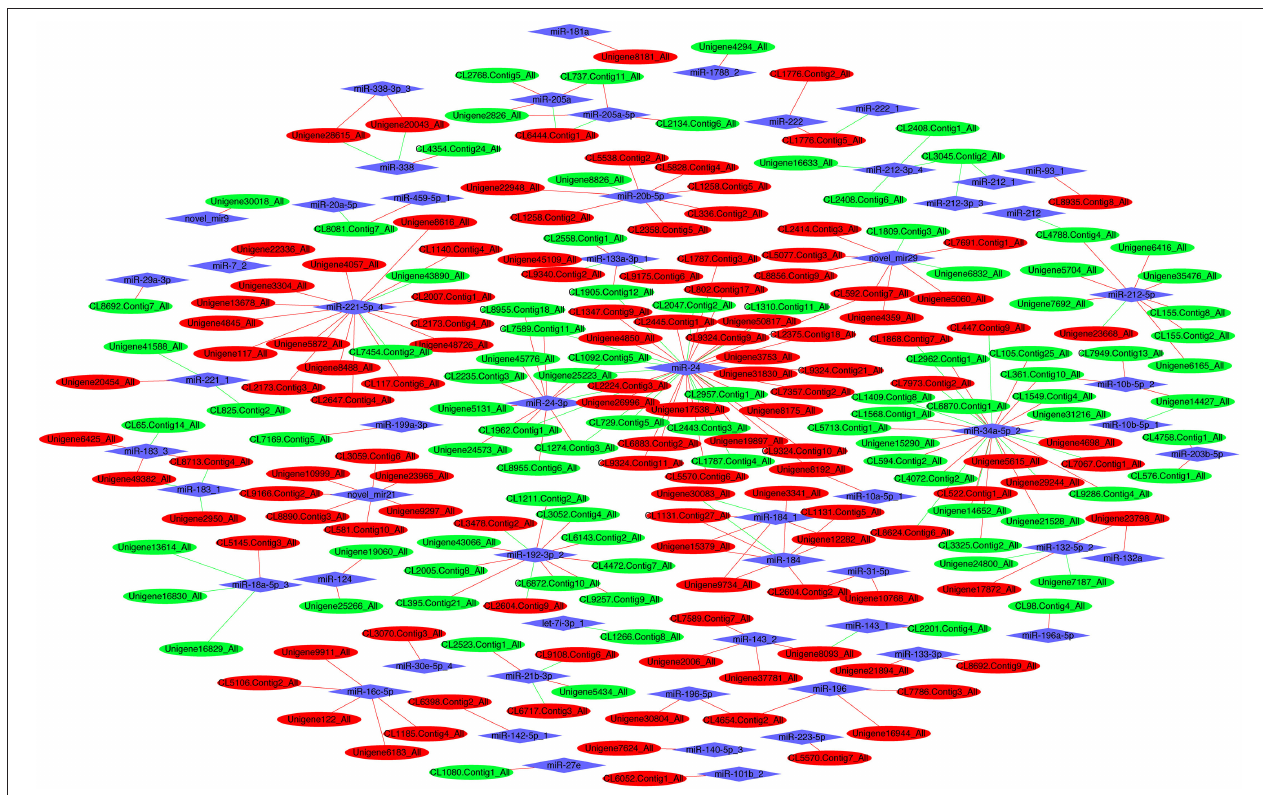
FIGURE 6 | The interaction network of differentially expressed miRNAs (DEmiRNAs) combined with differentially expressed mRNAs (DEGs). Red and green ellipses represent upregulated and downregulated mRNA, respectively. Blue diamonds represent DEmiRNAs. Red and green lines represent a positive and negative correlation, respectively, between DEmiRNAs and